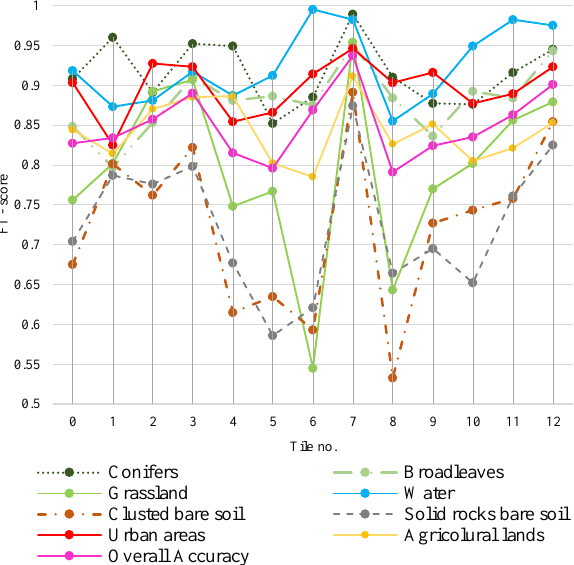
Figure 4. The changes in F1-score for each class through the epochs (tile no., on the abscissae).